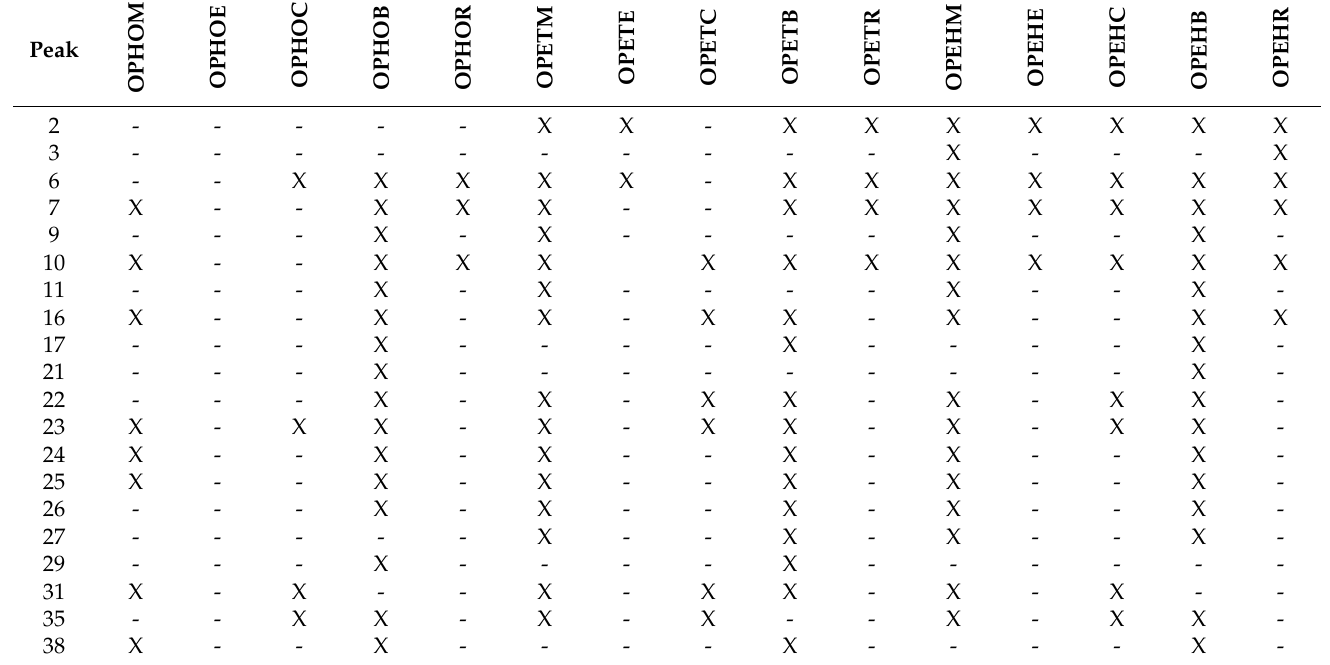
Table 6 (complete results in Supplementary Tables S3 and S4) show the presence of the compounds for each extract analyzed. Table 6. Presence of the identified compounds in the analyzed OFP extract samples (negative ion analysis).